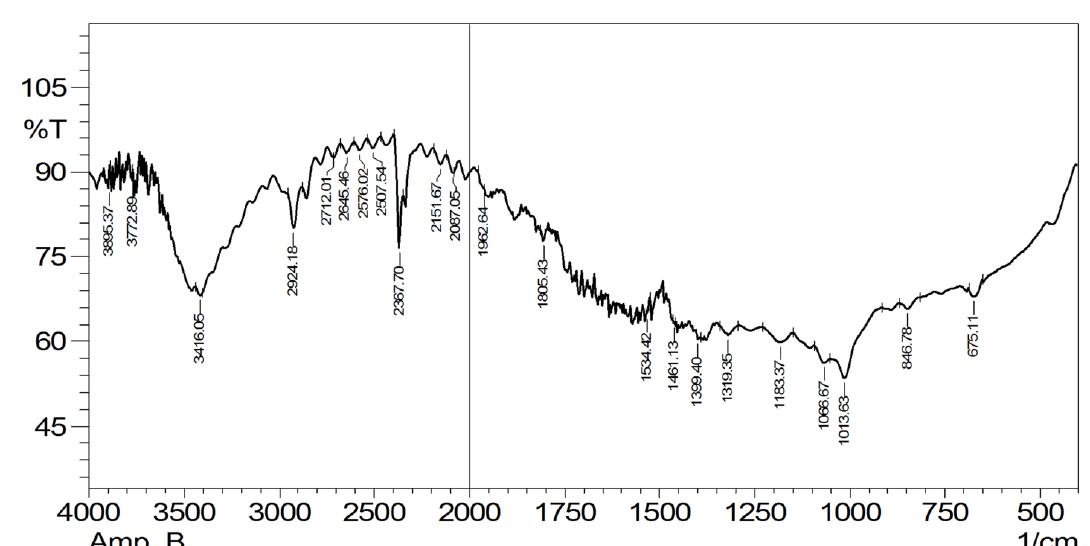
FIGURE 1 - FTIR spectrum of amphotericin B.